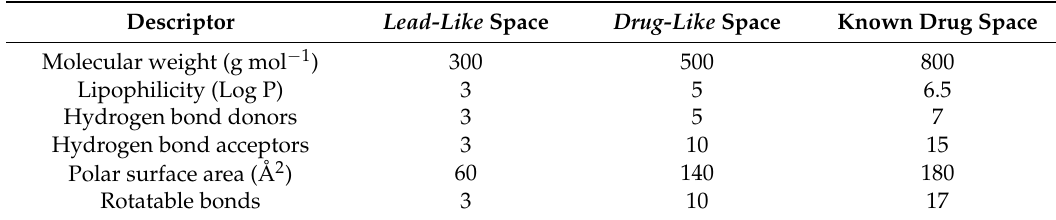
Table 1. Definition of lead-like , drug-like and known drug space (KDS) in terms of molecular descriptors. Descriptor Lead-Like